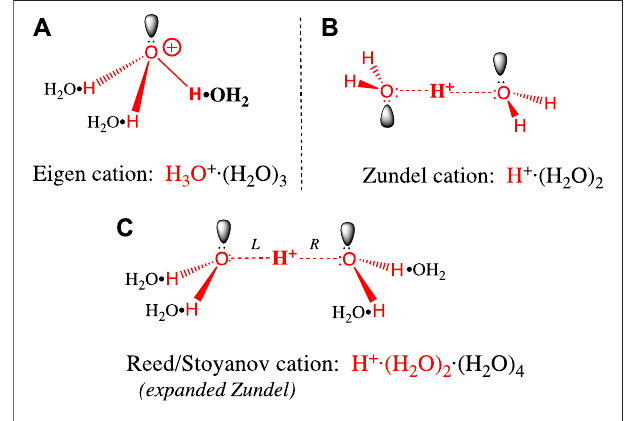
FIGURE 1 | (A) The Eigen cation: H + , the large red bolded H on the right is covalently bonded to a single water in its fi rst hydration shell. The three hydrogens in the resulting H 3 O + (red) each form hydrogen bonds with a black (cid:129) water (H 2 O ) forming the second hydration shell. Bonds are not drawn to scale: O-H covalent bonds (red) have 0.96 Å bond lengths, whereas the (cid:129) H 2 O H hydrogen bonds above are 1.4 – 1.7 Å long (Asthagiri et al., 2005) (Markovitch et al., 2008). (B) The Zundel cation: The central large red bolded H + is shared equally between two inner shell waters (red), to form an H 5 O 2+ dihydrate that features two symmetrical, unusually short and strong H-bonds. The symmetric trans conformation drawn here is the ground state in bulk water. (C) The Reed/Stoyanov cation: The Zundel dihydrate is expanded to (cid:129) include four black waters (H 2 O ) in a second hydration shell; the two central H-bondsinthedihydratecoreareslightlylongerandweakerthanintheZundel dihydrate (Reed, 2013). The asymmetric cis “ sawhorse ” conformation drawn here is believed to be the ground state at the hydrophobic phase/water